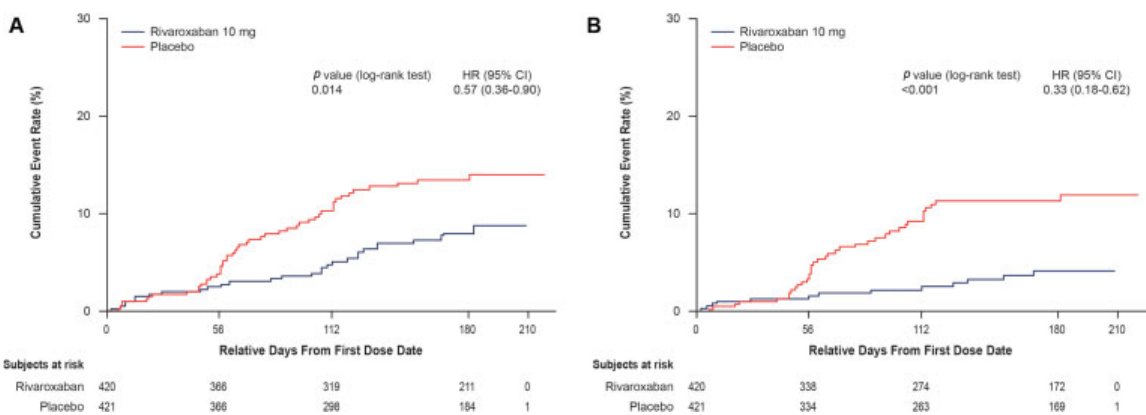
Fig. 1 Kaplan – Meier curves for all thromboembolic outcomes in all randomized patients, according to study group. Primary and secondary endpoints together included objectively con fi rmed, symptomatic, lower extremity, proximal or distal DVT; asymptomatic, lower extremity, proximal DVT; symptomatic upper extremity DVT; symptomatic or incidental nonfatal PE; or venous thromboembolism – related death; con fi rmed arterial thromboembolism; con fi rmed visceral thromboembolism, and con fi rmed distal asymptomatic DVT during the up-to-day 180 period ( A ): HR ¼ 0.57; 95% CI: 0.36 – 0.90; p ¼ 0.01 or the intervention period ( B ); HR ¼ 0.33; 95% CI: 0.18 – 0.62; p < 0.001. Every patient was accounted for in the analysis of the primary ef fi cacy composite endpoint for the intervention period. An imputation rule using the time patient in the double-blind period from randomization was implemented for patients who had never dosed to ensure patients were not excluded from on- treatment analysis for the ITT population. CI, con fi dence interval; DVT, deep-vein thrombosis; HR, hazard ratio; ITT, intent to treat; PE, pulmonary